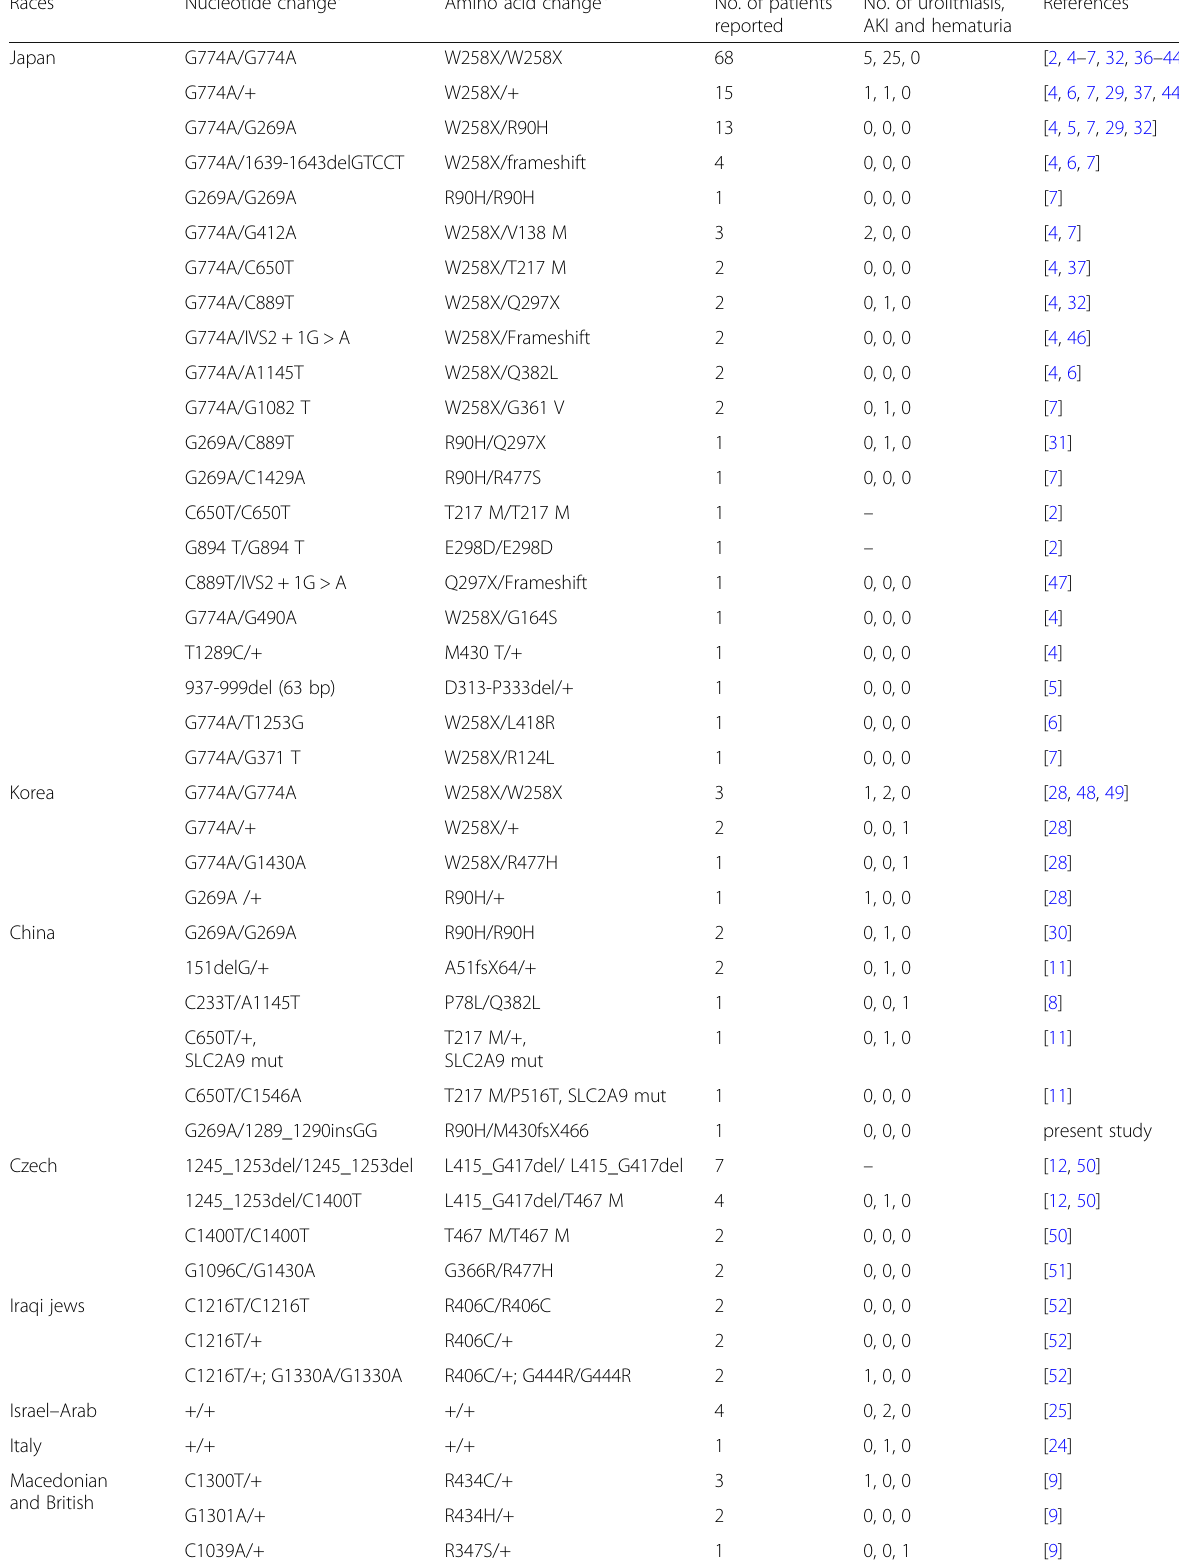
Table 4 Summary of all SLC22A12 gene mutations and clinical data for RHUC patients in varied races (mainly from case